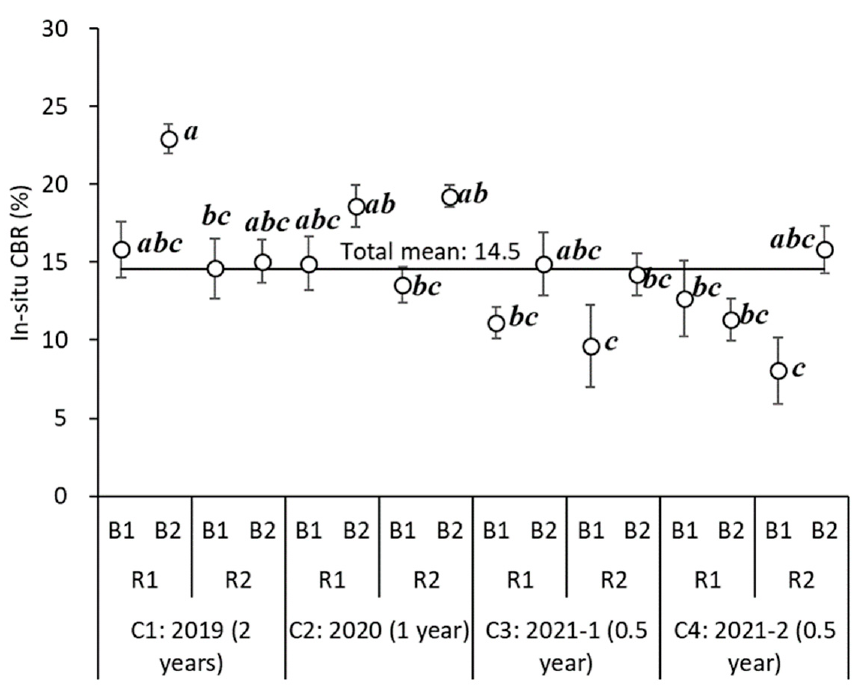
Figure 15. Interaction of Factor C (fiscal year of construction), Factor R (repetition), and Factor B (downhill side or uphill side) of Site 2 on in-situ CBR. The error bars and different letters have the same meaning as in Figure 9. p < 0.05, n = 5. B1: Downhill side, B2: Uphill side.